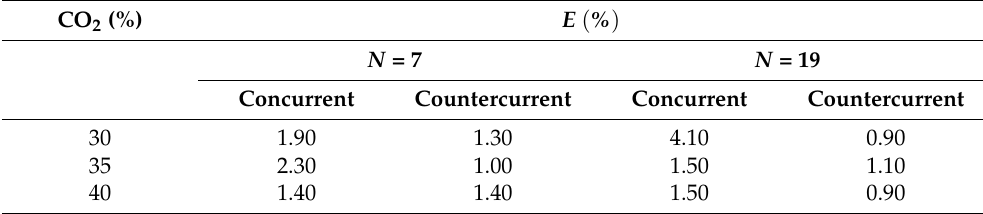
Table 2. The accuracy of the experimental